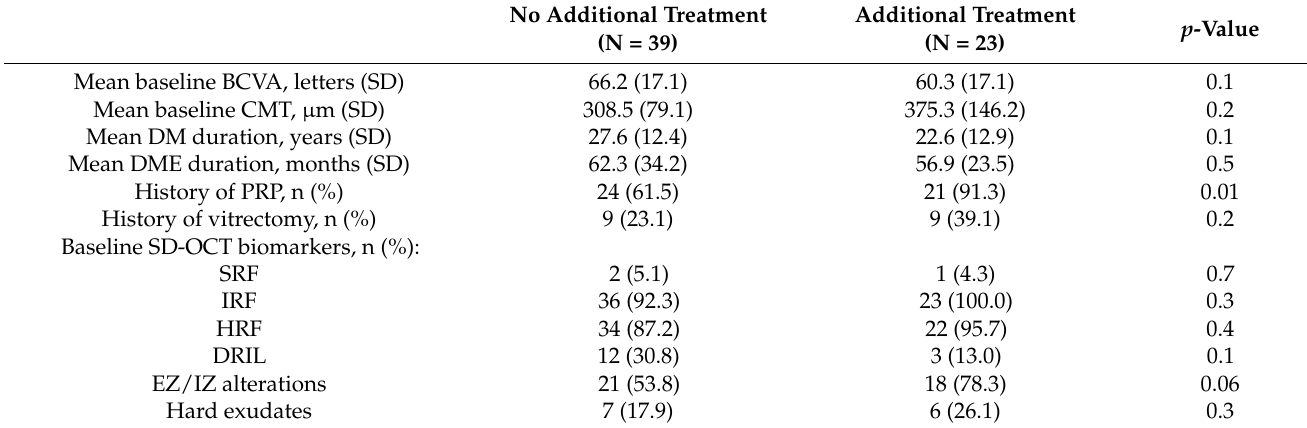
Table 3. Baseline associated factors for additional treatment after